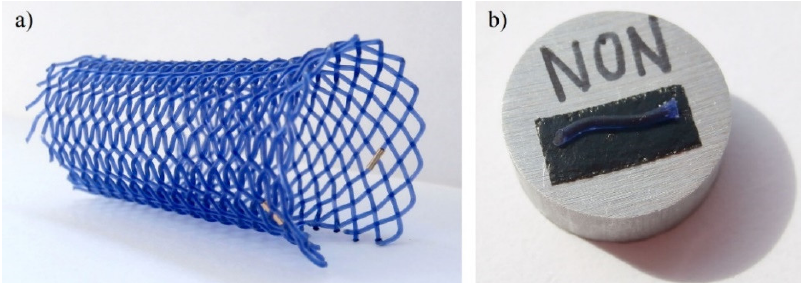
Figure 1. A biodegradable polydioxanone (PPDX) stent sample ( a ) and a piece of its fiber prepared for observations by a scanning electron microscope (SEM) ( b ).